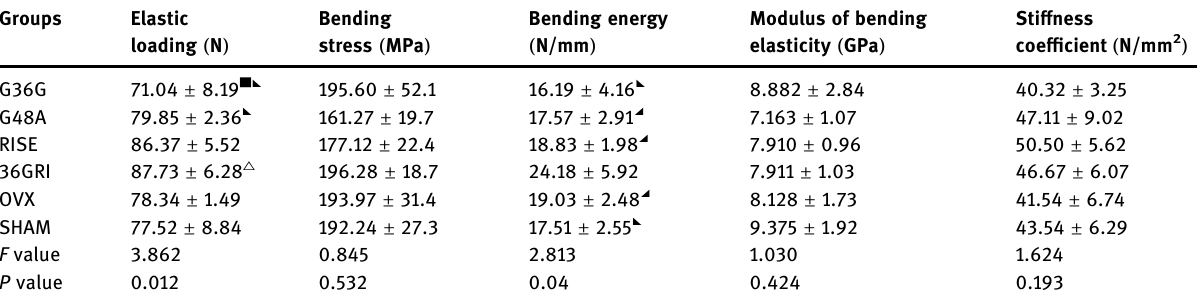
Table 4: E ff ects of di ff erent interventions on the indexes of three - point bending test of femur in rats ( x s ¯ ±